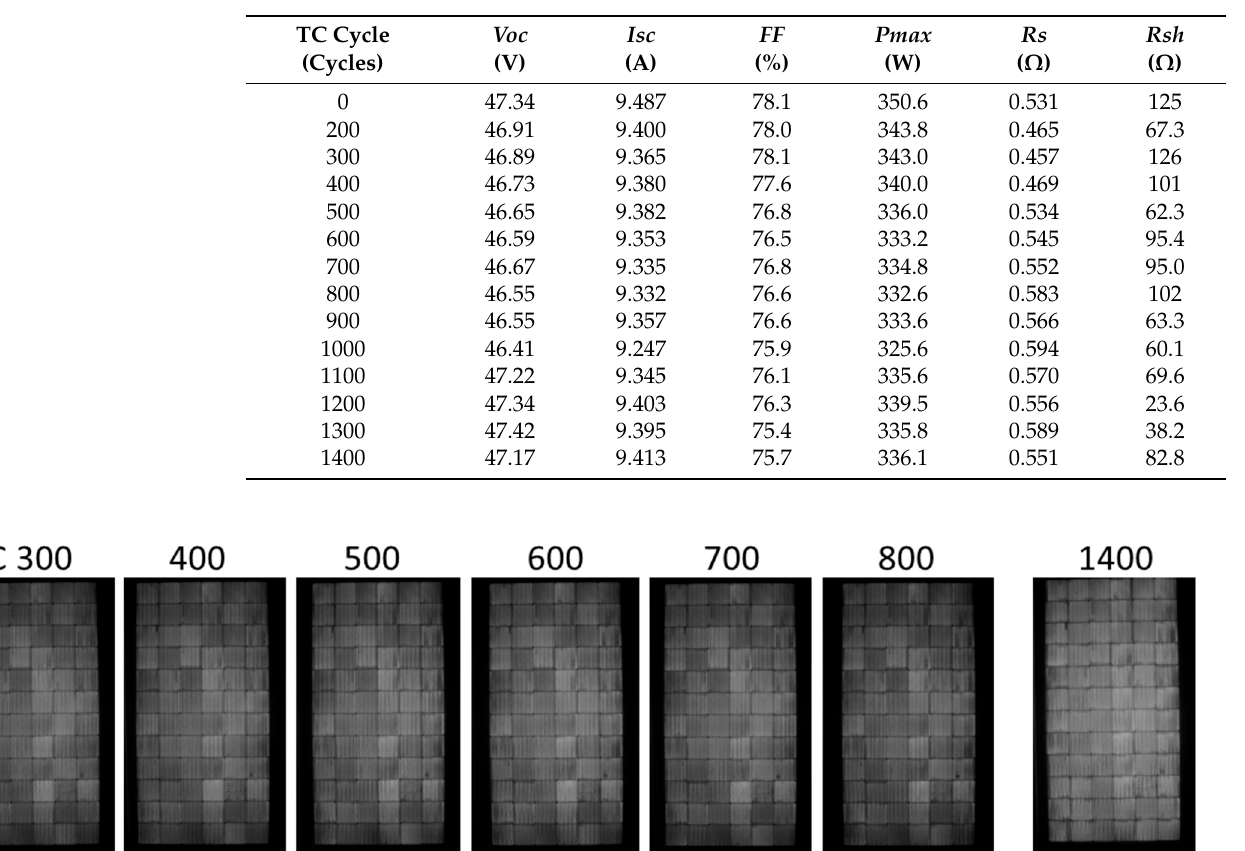
Figure 6. Change of module performance parameters with respect to temperature cycles. Table 2. Module performance parameters with temperature cycles.